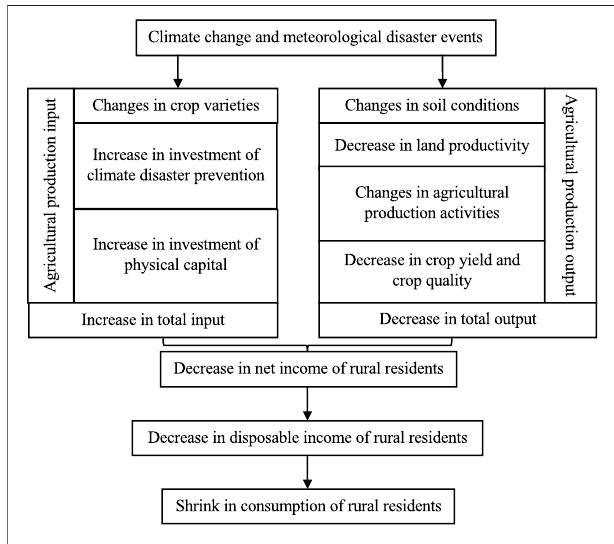
FIGURE 4 | Theoretical framework of the impact of climate change on the consumption of rural